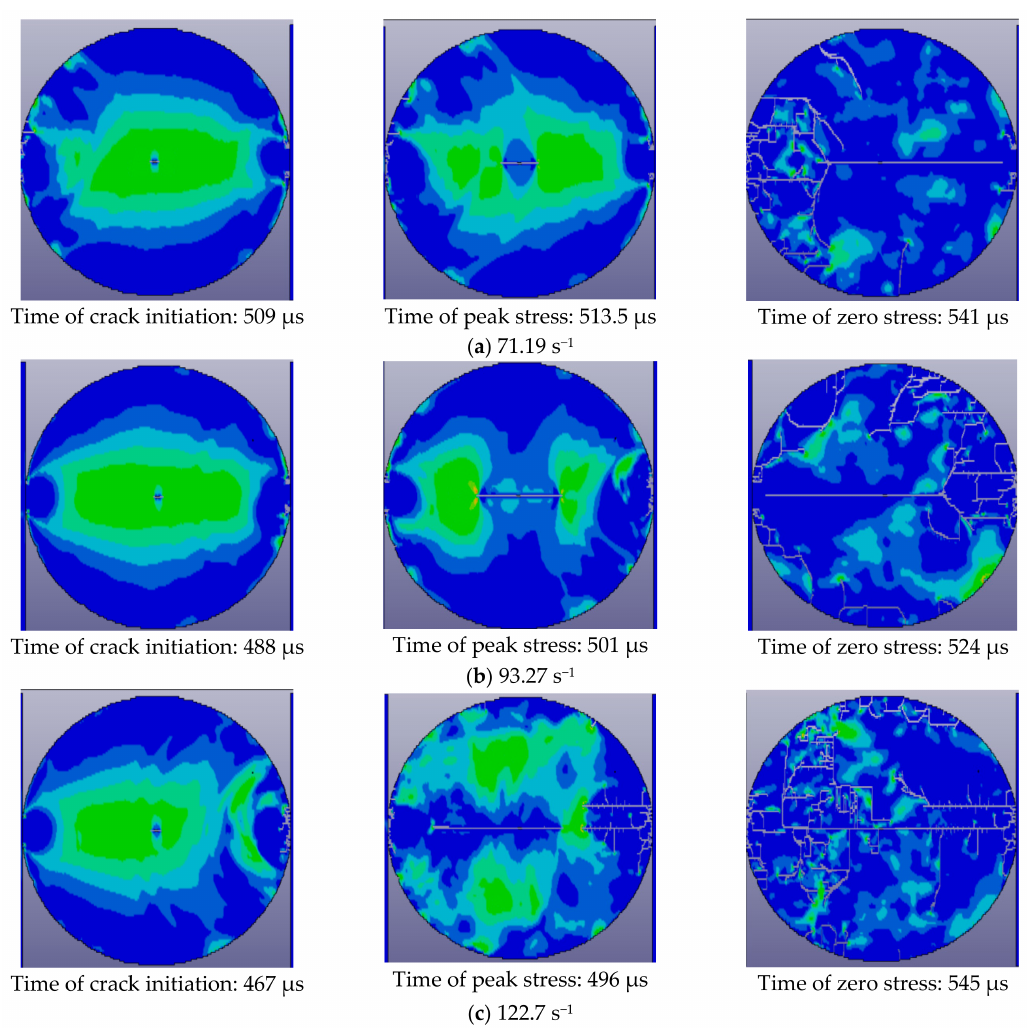
Figure 10. Failure process of the concrete at different strain rates. ( a ) Strain rate is 71.19 s − 1 ; ( b ) strain rate is 93.27 s − 1 ; ( c ) strain rate is 122.7 s − 1